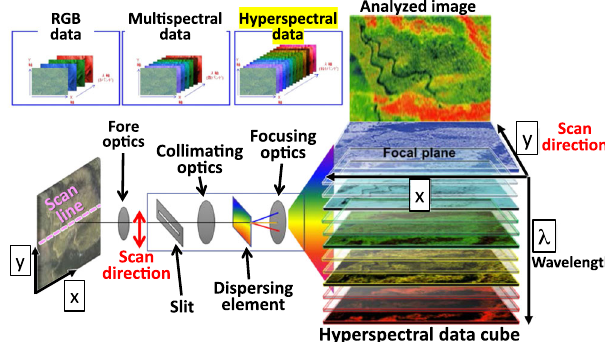
FIG. 7. Schematic of the hyperspectral imaging technology. Courtesy of EBA JAPAN Co., Ltd. [11].